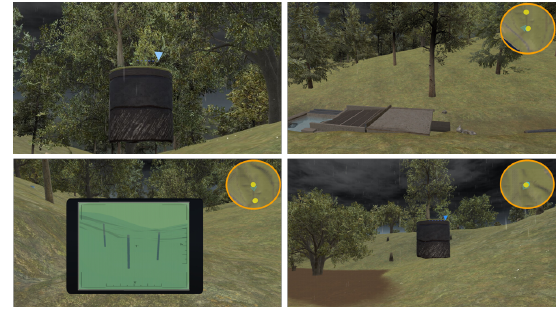
Figure 4. CZ Investigator: investigating the effect of natural and human process on the storage and flow of water.